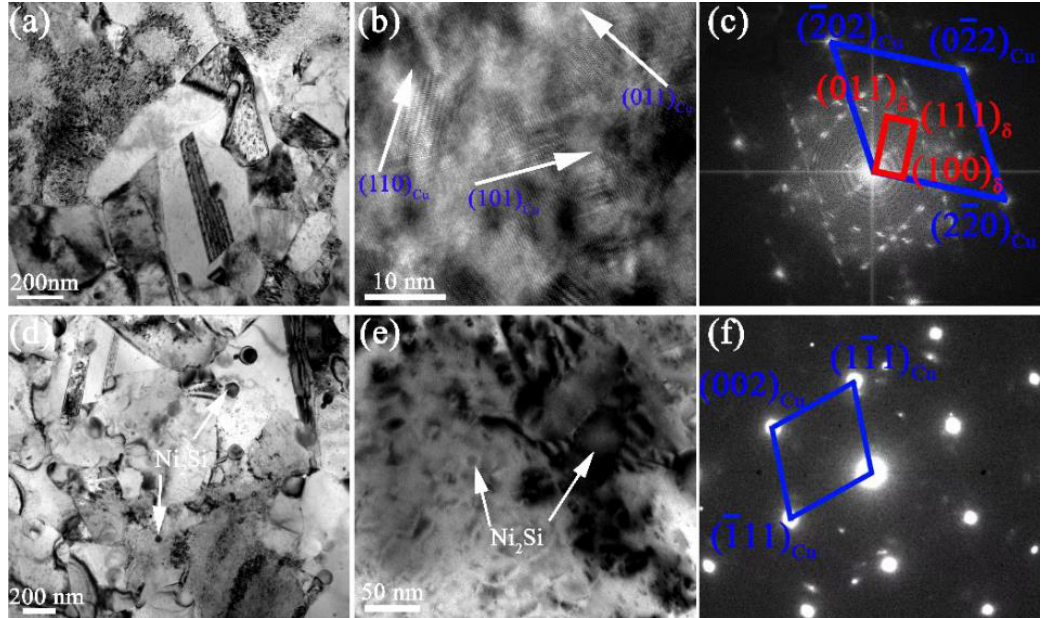
Figure 6. The evolution of precipitation of the Cu-Ni-Si alloy during the second step of aging at 450 °C for ( a ) 2.0 h and ( b ) the magnified photograph with ( c ) SADP and ( d ) 12.0 h, and ( e ) the magnified photograph with ( f ) SADP.